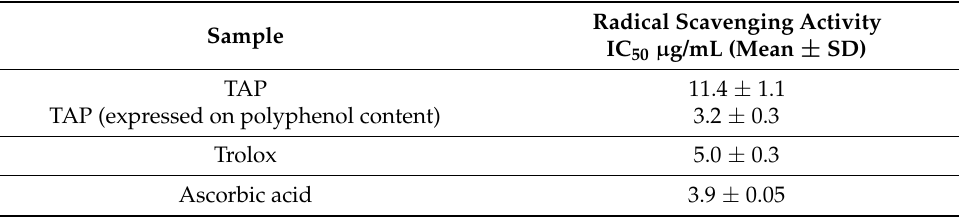
Table 1. Direct radical scavenging activity of TAP extract, TAP expressed on the basis of polyphenol content, Trolox, and ascorbic acid. Results are reported as mean ± standard deviation.